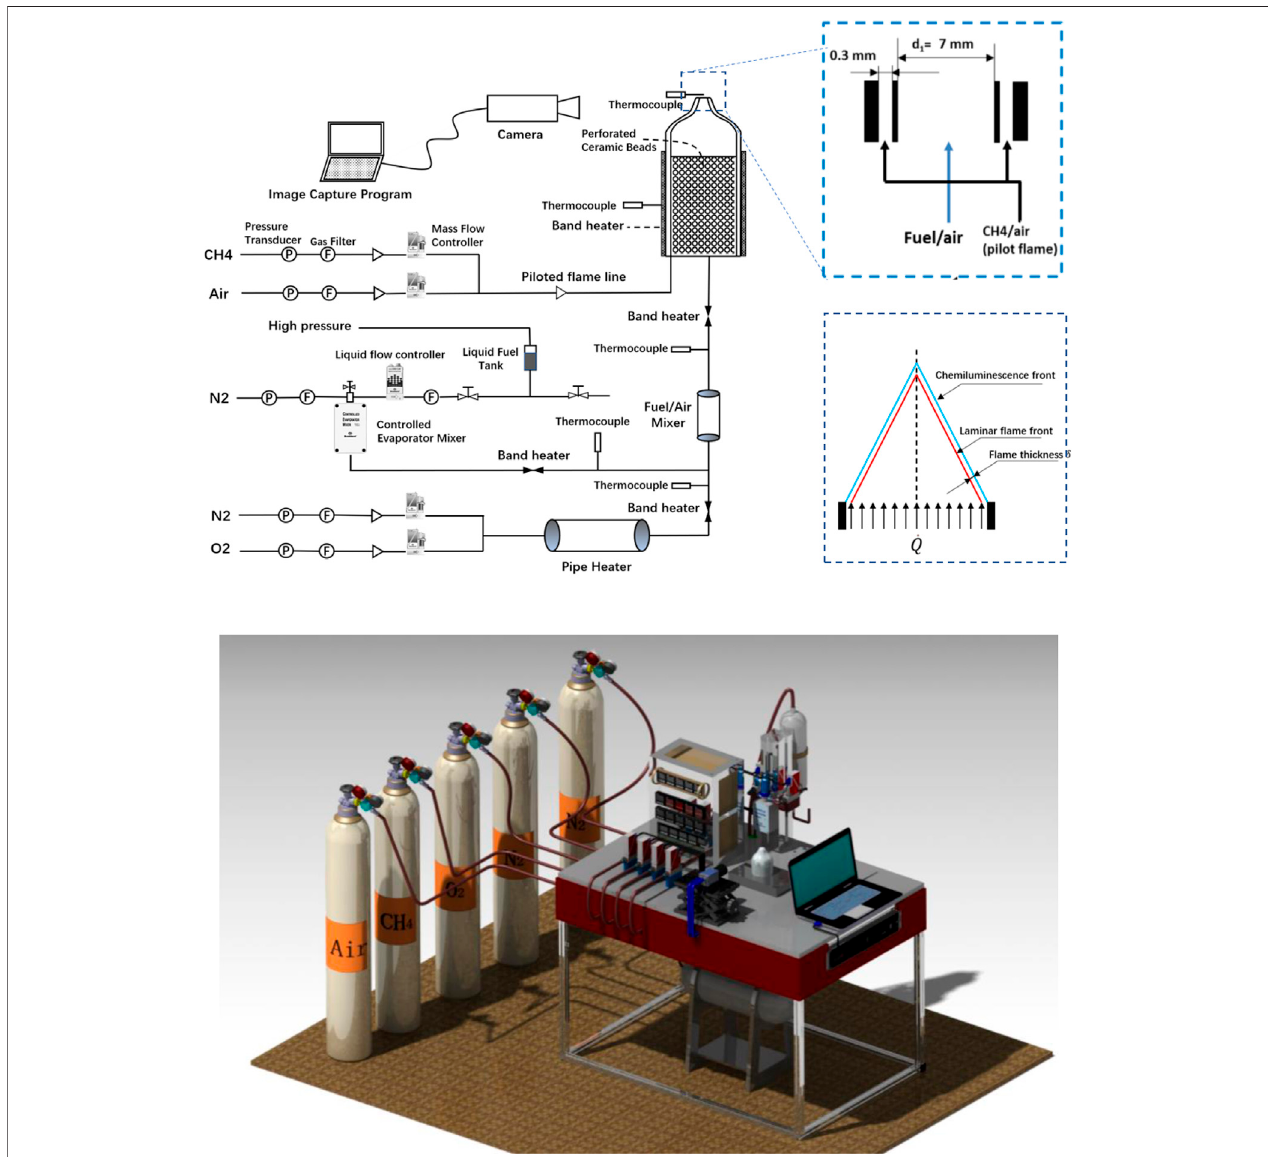
FIGURE 1 | Schematic of the experimental setup of laminar fl ame speed